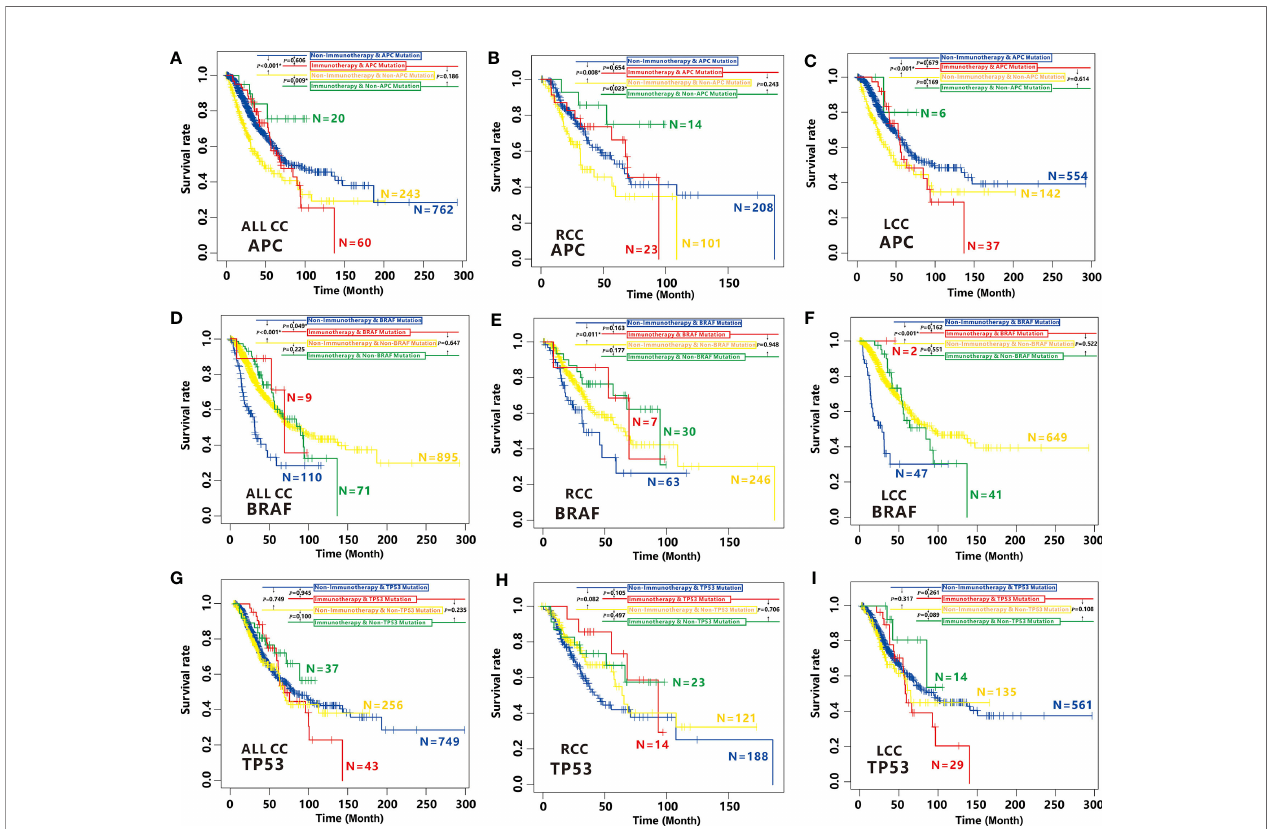
FIGURE 9 | Effects of APC , BRAF and TP53 mutation on immunotherapy ef fi cacy in CC. (A – C) Comparison of survival curves among APC -mutated patients with non-immunotherapy (blue), APC -mutated patients with immunotherapy (red), non- APC -mutated patients with non-immunotherapy (yellow) and, non- APC - mutated patients with immunotherapy (green) by Kaplan – Meier analysis in CC cohort (A) , RCC cohort (B) and LCC cohort (C) . (D – F) Comparison of survival curves among BRAF -mutated patients with non-immunotherapy (blue), BRAF -mutated patients with immunotherapy (red), non- BRAF -mutated patients with non- immunotherapy (yellow) and, non- BRAF -mutated patients with immunotherapy (green) by Kaplan – Meier analysis in CC cohort (D) , RCC cohort (E) and LCC cohort (F) . (G – I) Comparison of survival curves among TP53 -mutated patients with non-immunotherapy (blue), TP53 -mutated patients with immunotherapy (red), non- TP53 -mutated patients with non-immunotherapy (yellow) and, non- TP53 -mutated patients with immunotherapy (green) by Kaplan – Meier analysis in CC cohort (G) , RCC cohort (H) and LCC cohort (I)